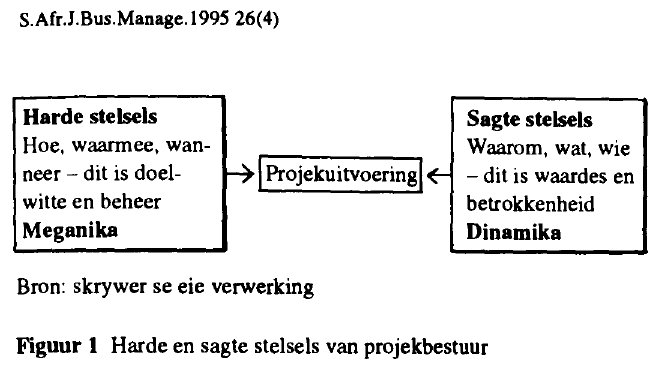
Figuur 1 Harde en sagte stelsels van projekbestuur In die derde plek impliseer die voorafgaande besprekings dat 'n gemeenskapsorientering van die bestuur van die projek fundamenteel is tot die suksesvolle implementering